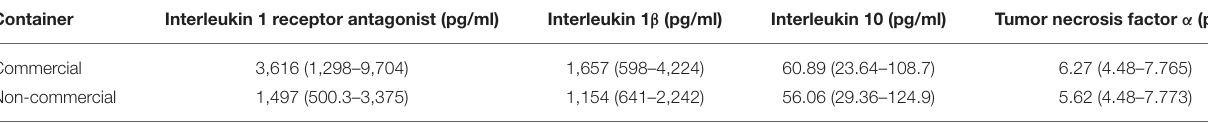
TABLE 2 | Median (interquartile) concentrations for cytokines measured for each ACS production method.